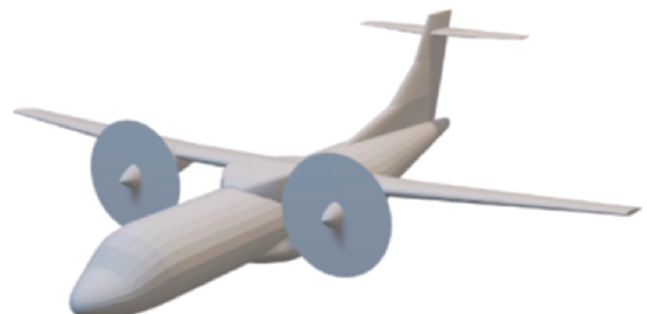
Figure 4. Configuration A.